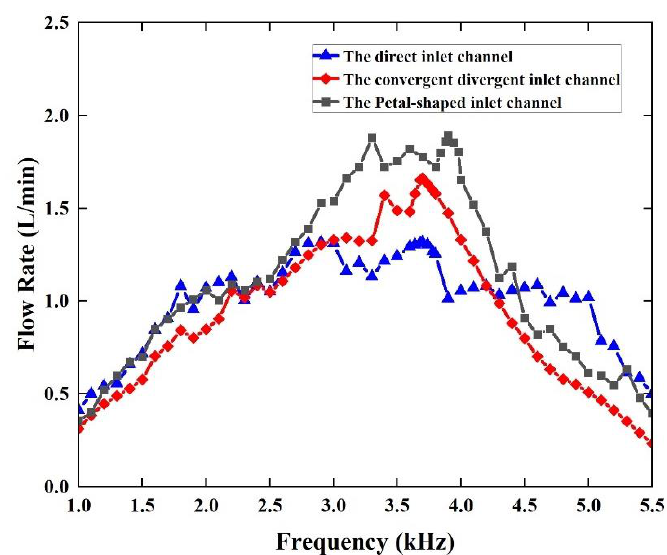
Figure 9. Flowrate curve of different prototypes.